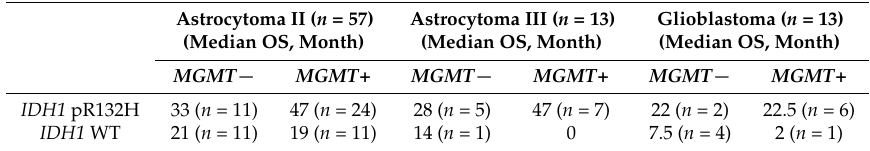
Table 2. Distribution of the mutation in IDH1 and MGMT promoter methylation among the patients according to their histopathological diagnosis (WHO II, III, IV). OS, Overall Survival.